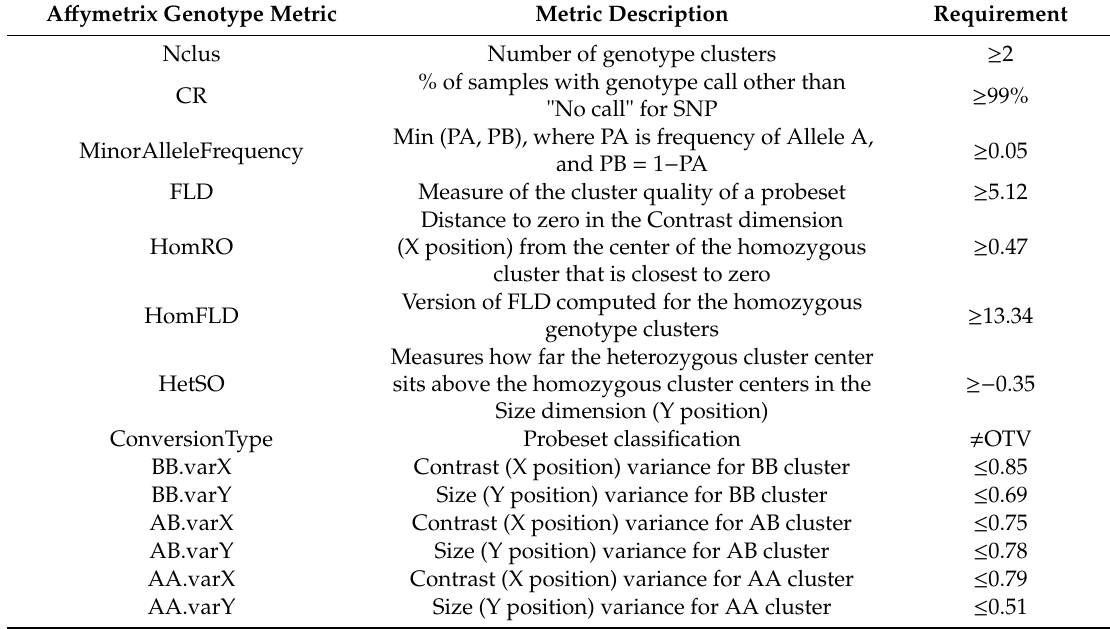
Table 1. Genotype quality metrics provided by A ff ymetrix and the requirements used in quality control